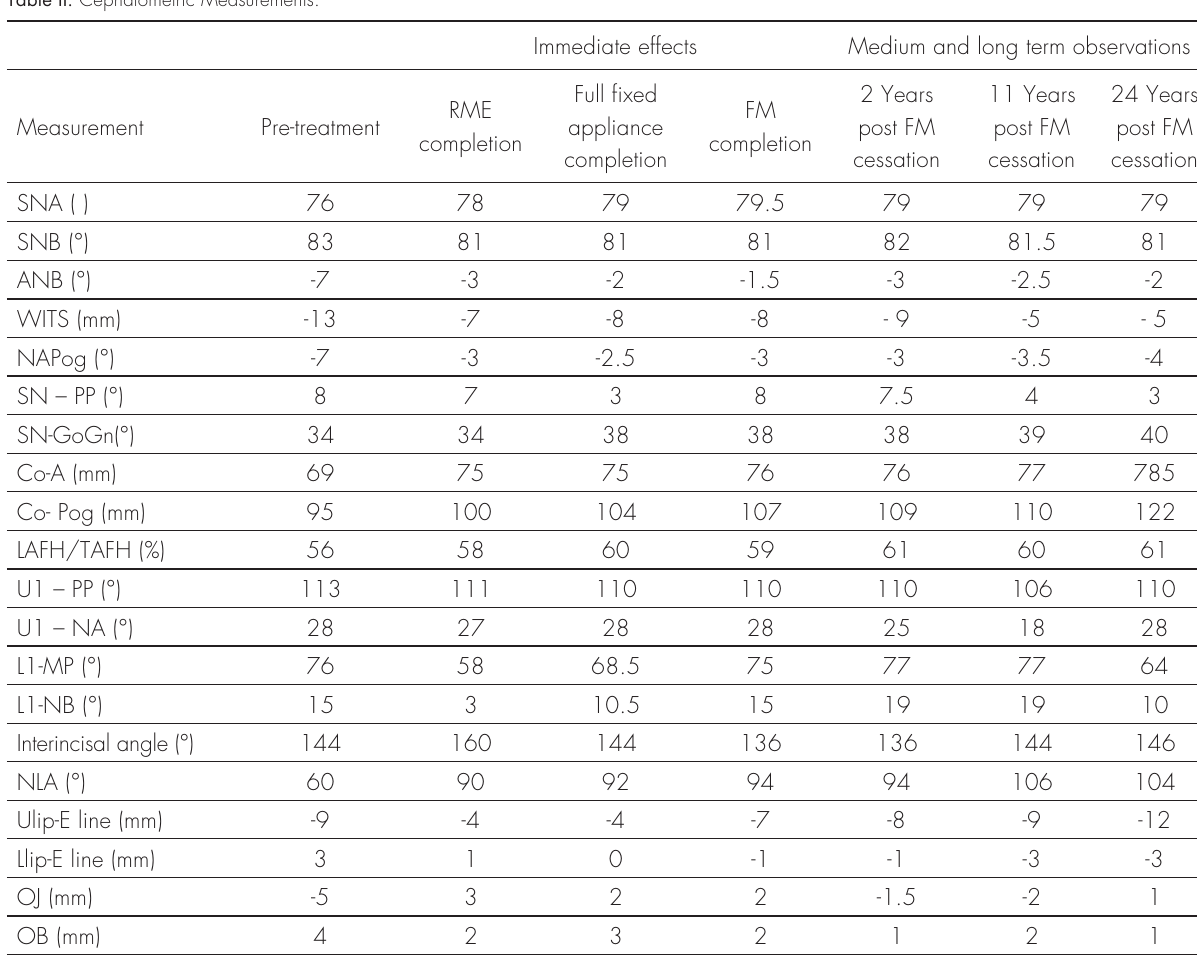
Table II. Cephalometric Measurements.